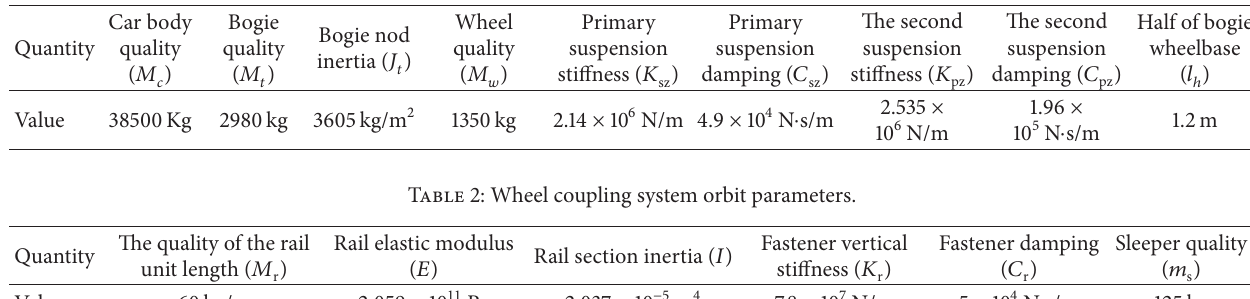
Table 1: Vehicle parameters.